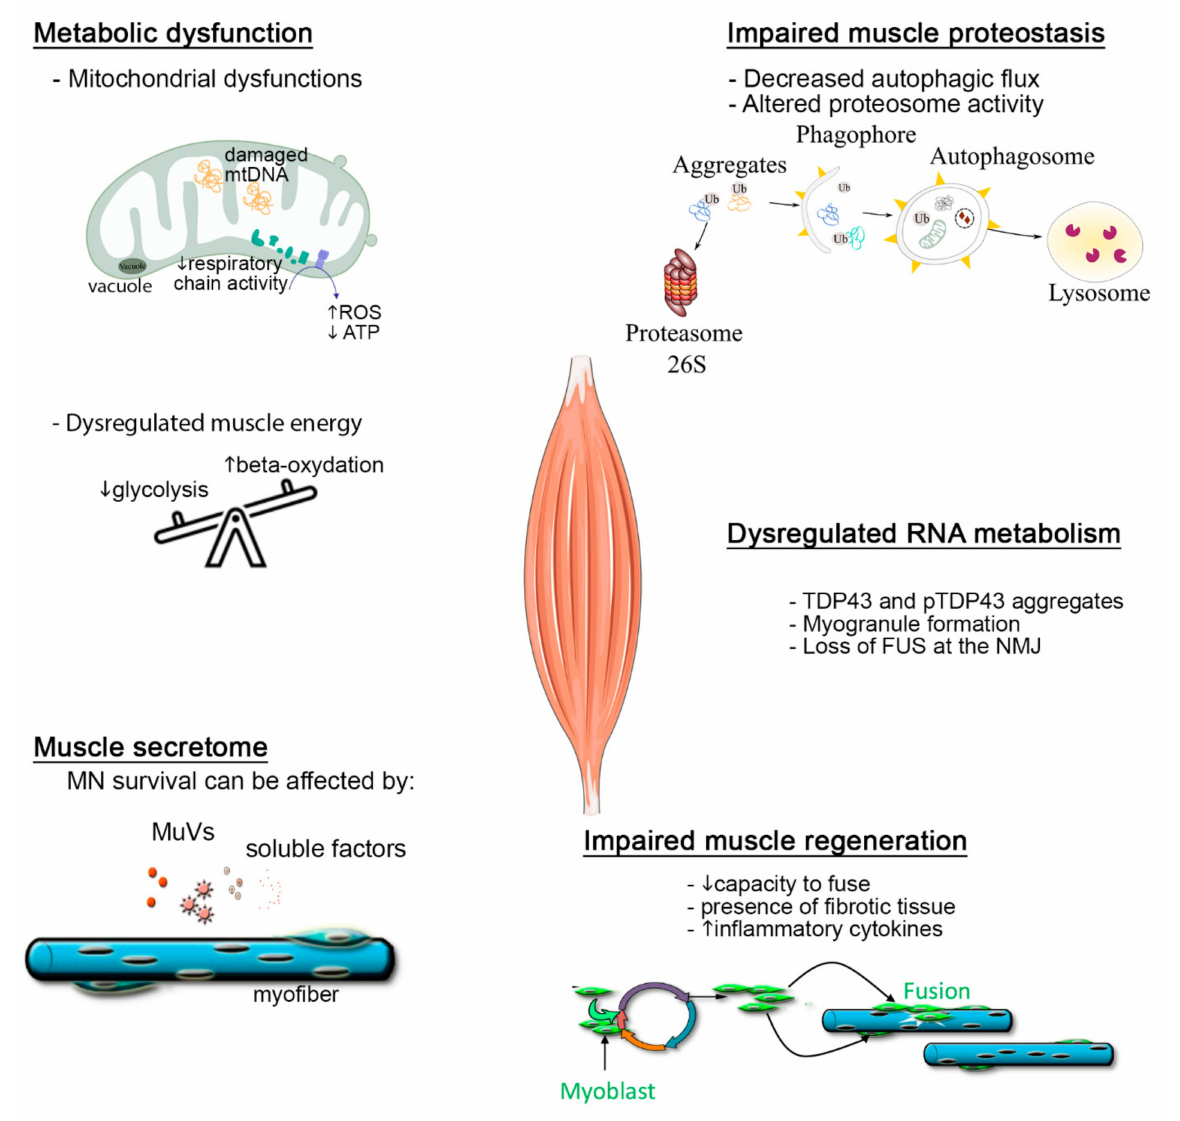
Figure 1. Summary of the cellular and molecular events affected in the skeletal muscles of ALS patients and